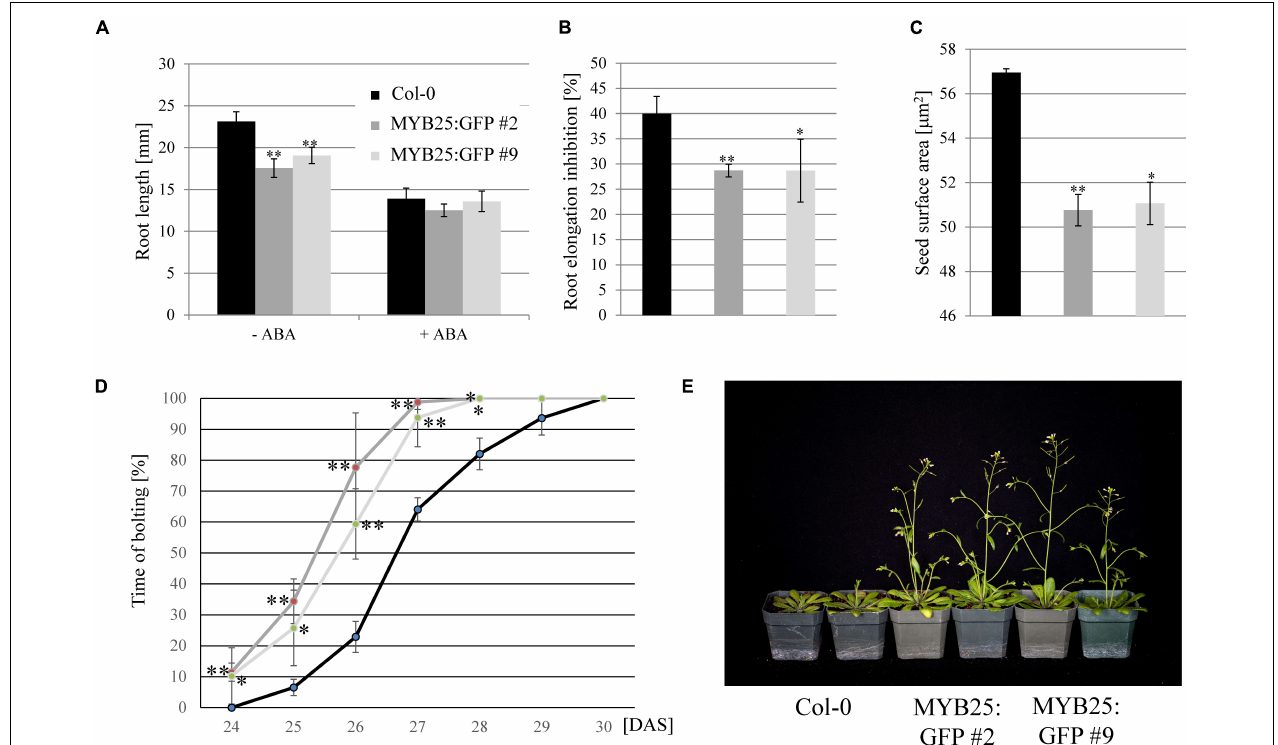
FIGURE 7 | Overexpression of MYB25 affects root and seed development as well as flowering time. (A) MYB25:GFP plants have shorter roots compared to wild type ( n = 30). (B) Presence of ABA (20 µ M) causes a significantly higher reduction in root elongation in wild type plants than in the MYB25:GFP plants. (C) Plants with elevated MYB25:GFP expression develop smaller seeds compared to wild type ( n = 30). (D,E) MYB25:GFP overexpressing plants show an early flowering phenotype ( n = 20). DAS, Days After